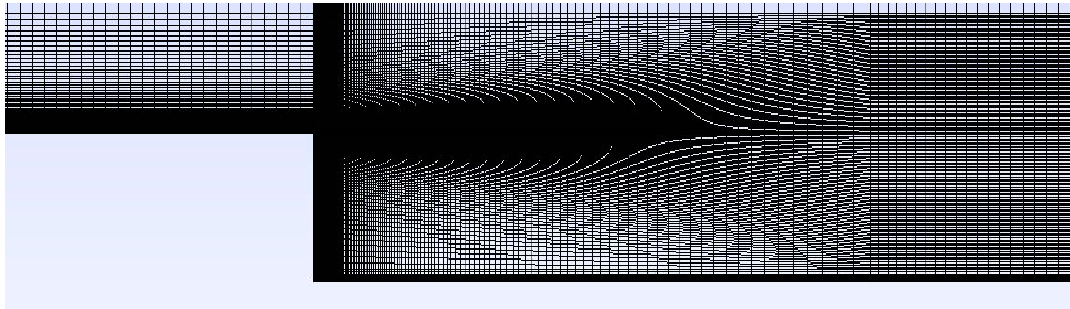
Figure 1. View of the backward step mesh near the step.